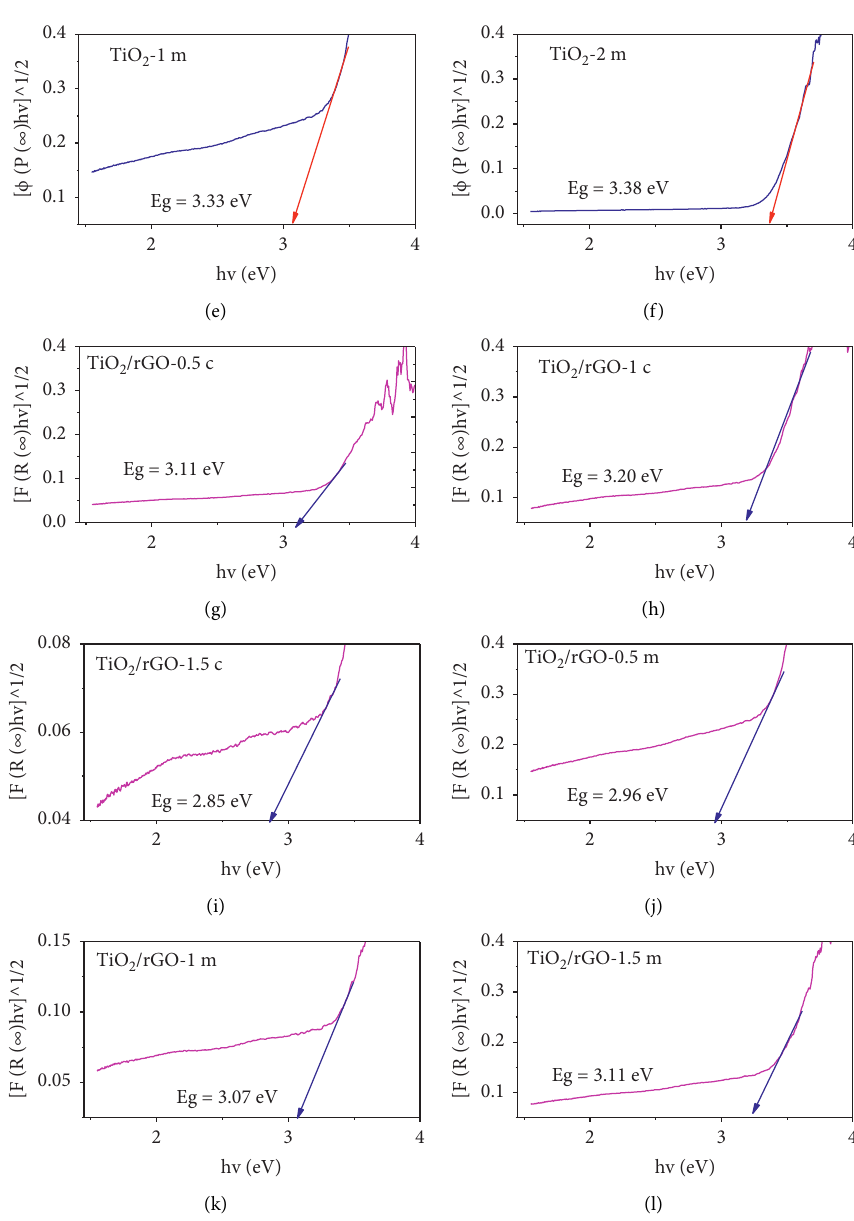
Figure 7: Tauc plot of TiO 2 NPs and TiO 2 /rGO NCs obtained using CS and MA peel waste